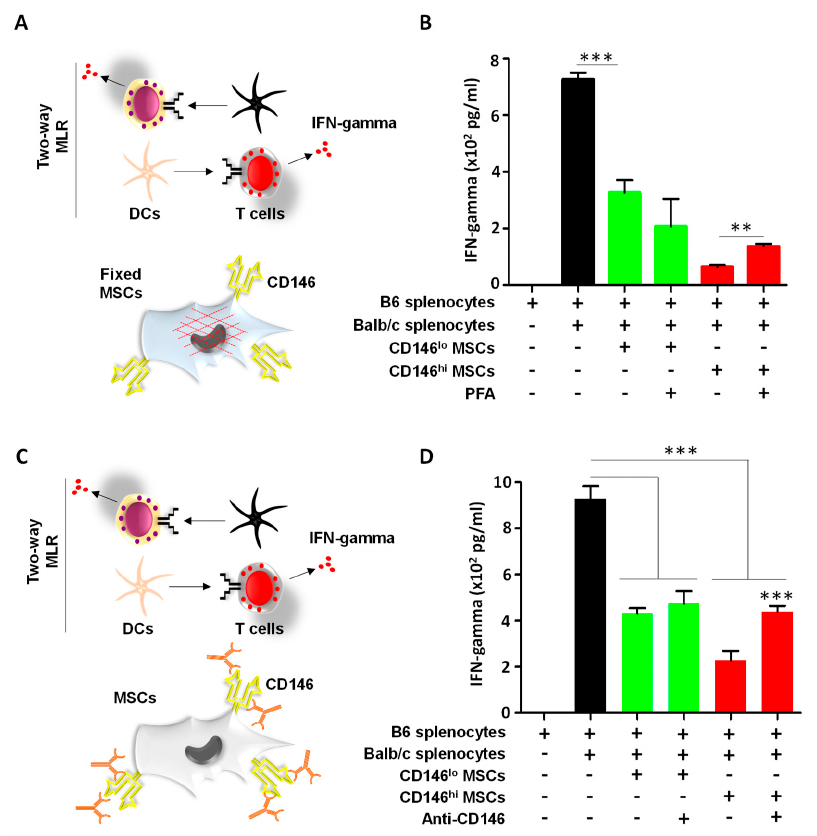
Figure 3. CD146 hi MSCs require both soluble and cell–cell contact to inhibit activated T cells. ( A ) Schematic diagram showing the design of the inhibitory experiment performed using pre-fixed MSCs. ( B ) IFN-gamma quantification of the experiment depicted in panel A. ( C ) Schematic diagram showing the design of the inhibitory experiment performed using the anti-CD146 neutralizing polyclonal antibodies. ( D ) IFN-gamma quantification of the experiment depicted in panel C. For panels B and D, n = 5/group with ** p < 0.01 and *** p <